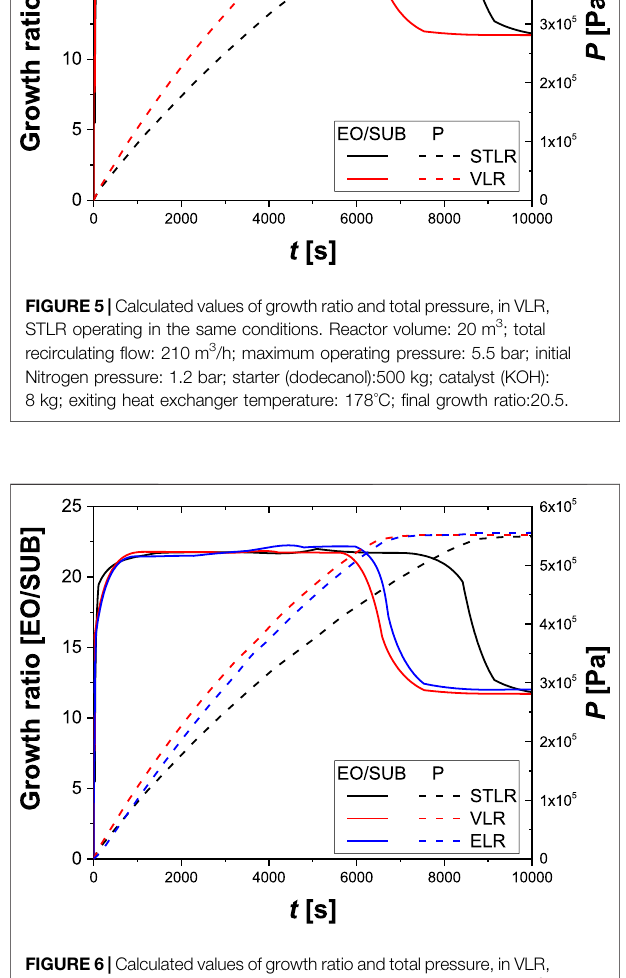
Frontiers in Chemical Engineering |